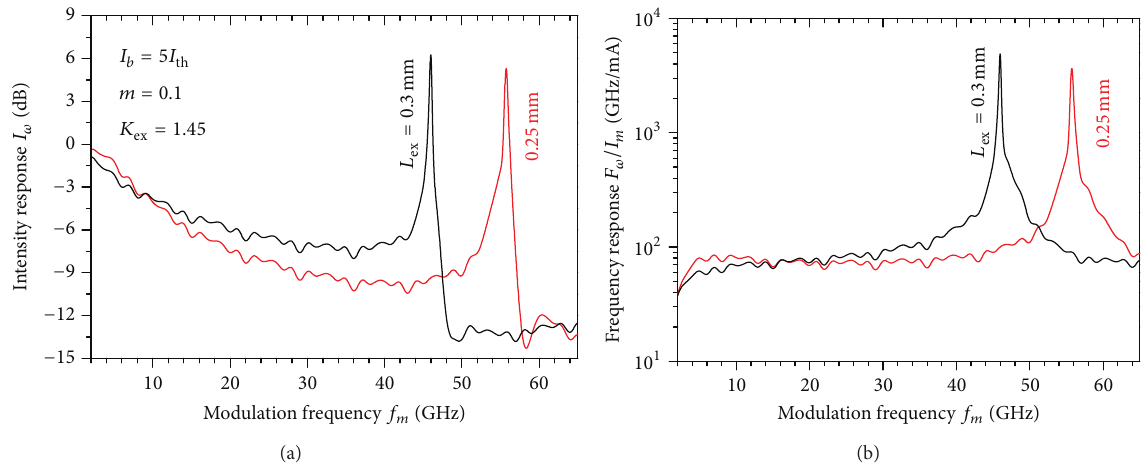
= 1.45 when 𝐿 = 0.25 and 0.30 mm with 𝑚 = 0.1. ex ex